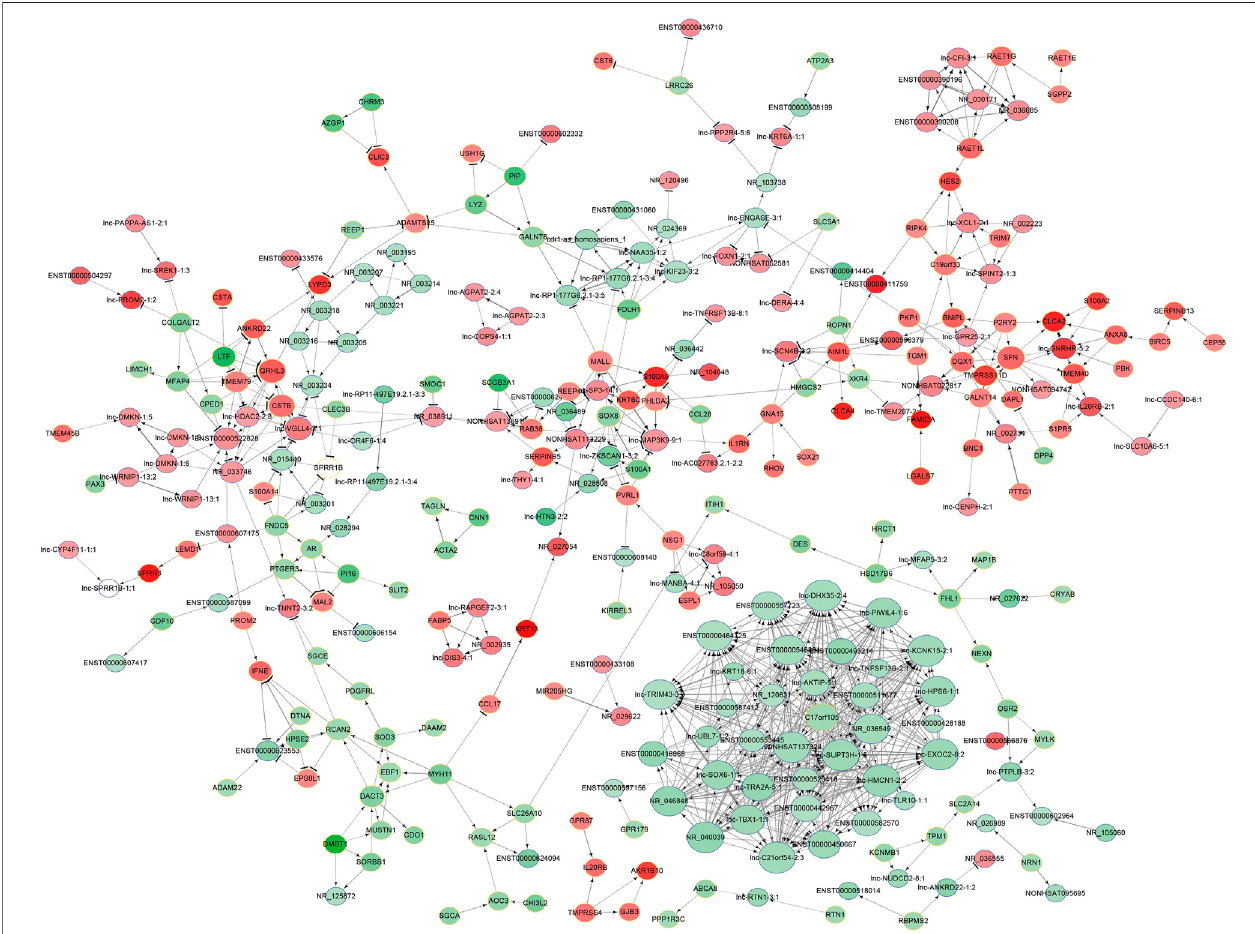
FIGURE3| PredictionofthelncRNA-mRNAassociationnetwork.Thecoexpressionnetworkwascomposedof305networknodesand769connectionsbetween 155 lncRNAs and 150 coding genes. The red and green circles denote high and low relative expression, respectively. The arrow represents positive regulation, and the fl at-head line represents negative regulation.